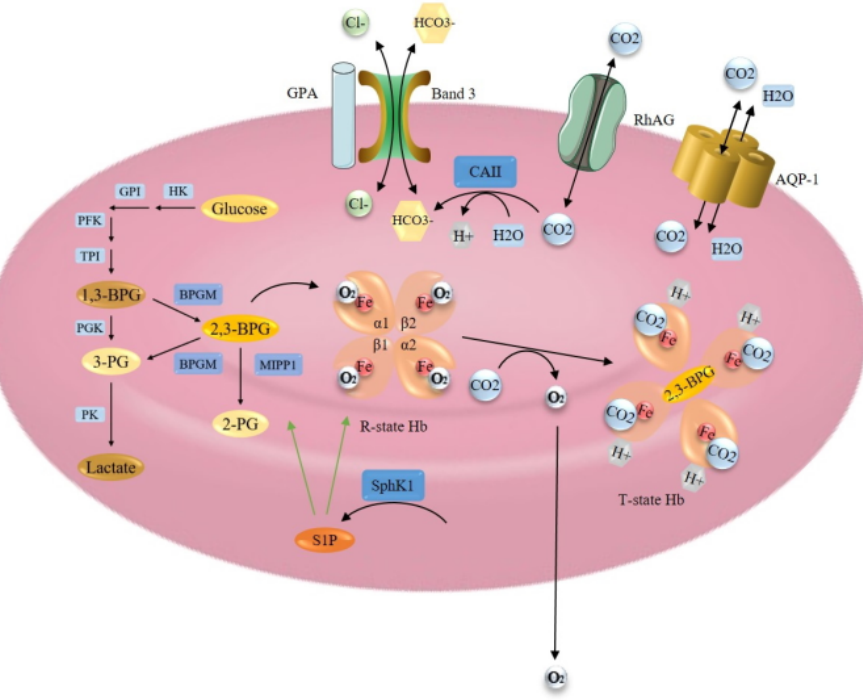
Figure 3. Erythrocyte and hemoglobin structure and function modulation, gas transport and glycoly- sis pathway, including Rapoport-Luebering shunt. Green line indicates the activation effect. Black line indicates transition (Figure was created using Reactome database